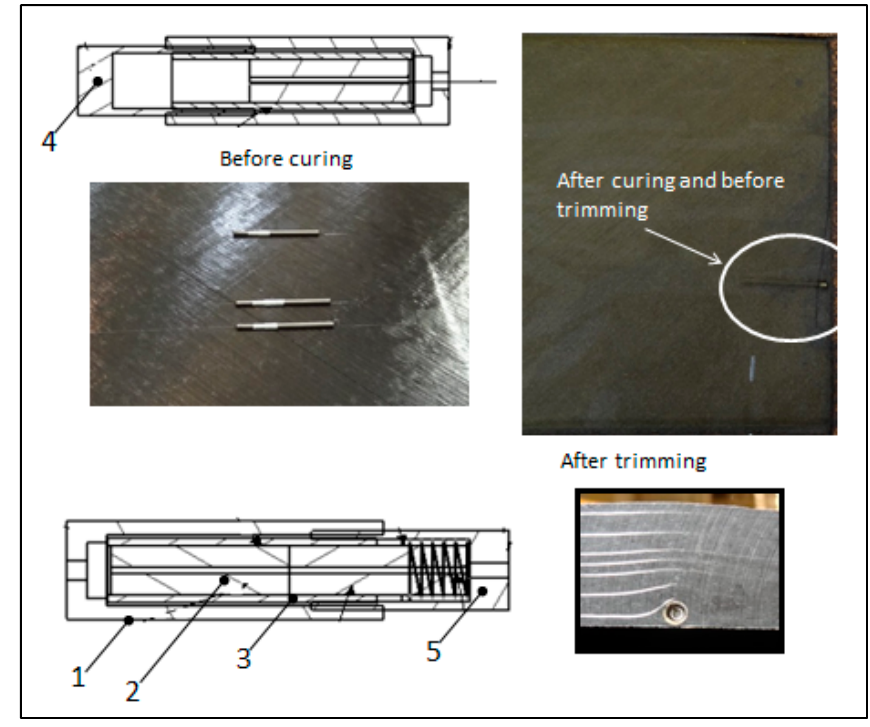
Figure 4. Optical fiber connector solution.